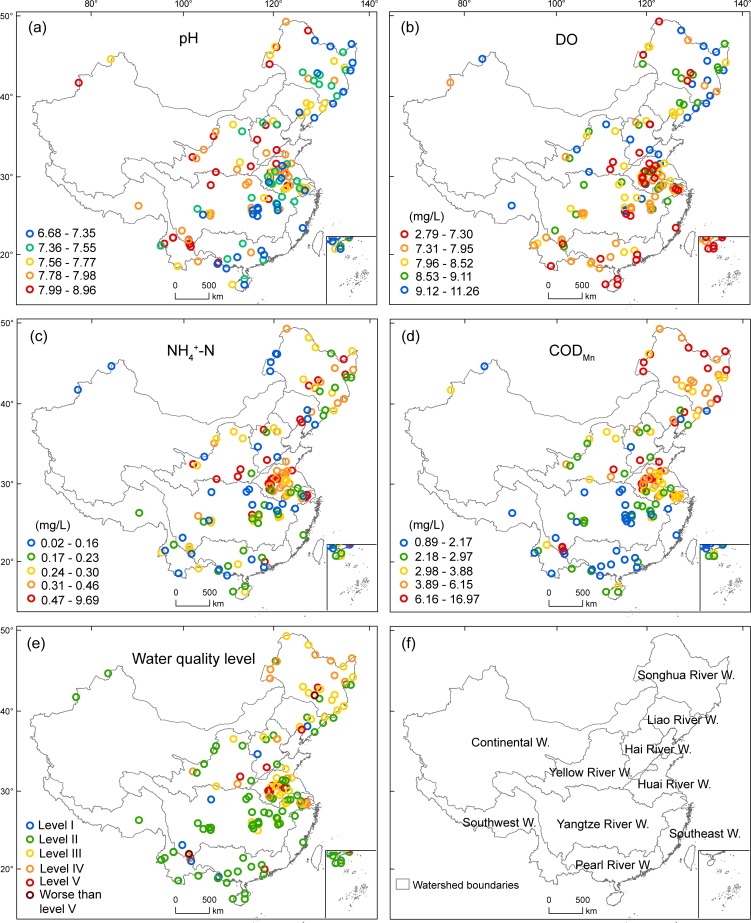
Values of four water quality parameters (a–d) and water quality level (e) at 145 monitoring sites in China, averaged from the weekly published data over the period between January 2014 and December 2016. (a–d) are in quantile classification. W. in (f) is the abbreviation for watershed. Maps are in Albers projection. Insets in the bottom right of maps show the south boundary of China, including all islands in the South China Sea.